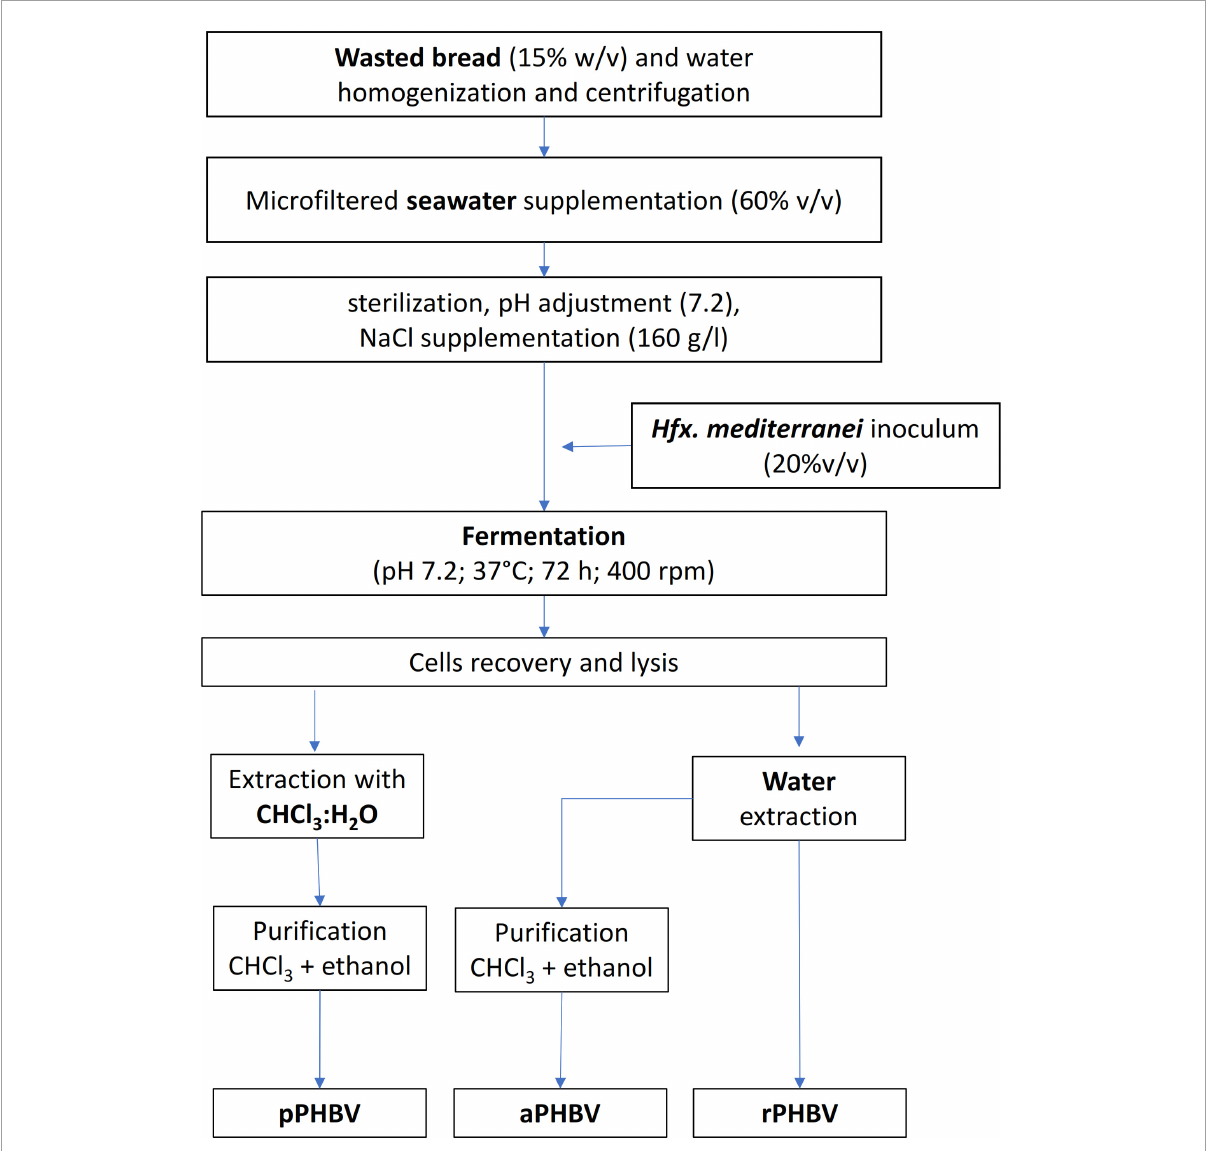
FIGURE1 Flow chart of the PHBV production and recovery from the wasted bread/seawater substrate: pPHBV, obtained from the CHCl 3 :H 2 O separation and the precipitation with cold ethanol; rPHBV, obtained by the replacement of the CHCl 3 :H 2 O separation with repeated washing with water; aPHBV, obtained by the replacement of the CHCl 3 :H 2 O separation with repeated washing with water but followed by solubilization in CHCl 3 and purification with cold